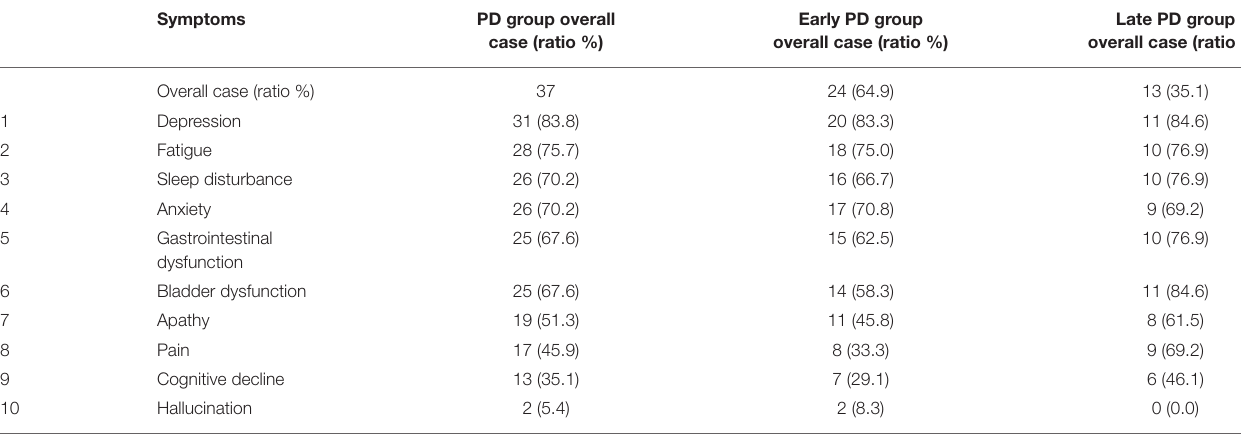
TABLE 3 | Number and rate of non-motor symptoms (according to the results of MDS-UPDRS and NMSS scale).